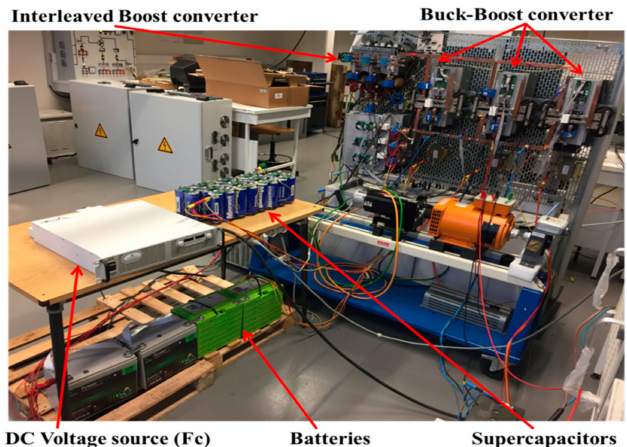
Figure 25. Reduced scale test